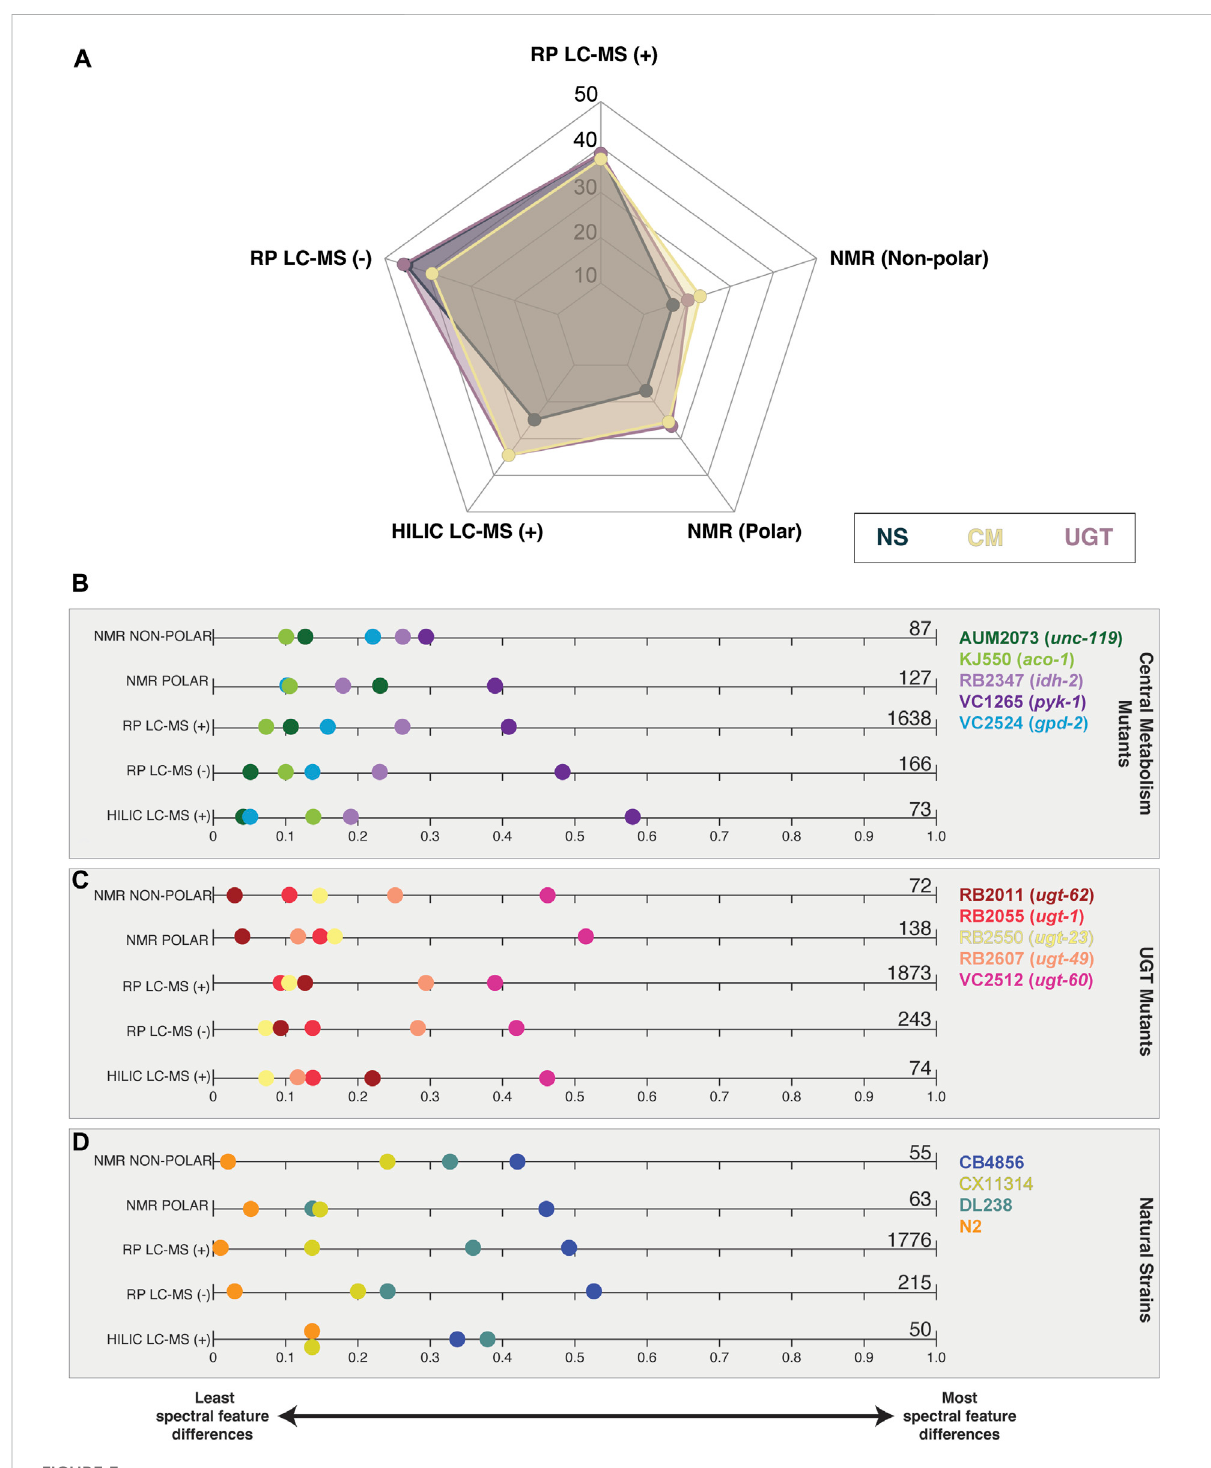
FIGURE 3 Summary of signi fi cant spectral features found in each analytical platform and across the three studies. (A) Percent of signi fi cant features. The total number of signi fi cant features in all strains, by study, is used as the denominator for each of the fi ve technologies. Signi fi cant spectral features identi fi ed in at least one strain by study are displayed for (B) central metabolism mutants, (C) UGT mutants, and (D) natural strains. Zero indicates the strain has no signi fi cant spectral feature differences from PD1074, while one indicates that all spectral feature differences from PD1074 are present in that strain. Signi fi cant feature totals are summarized at the end of the plot and detailed in Table